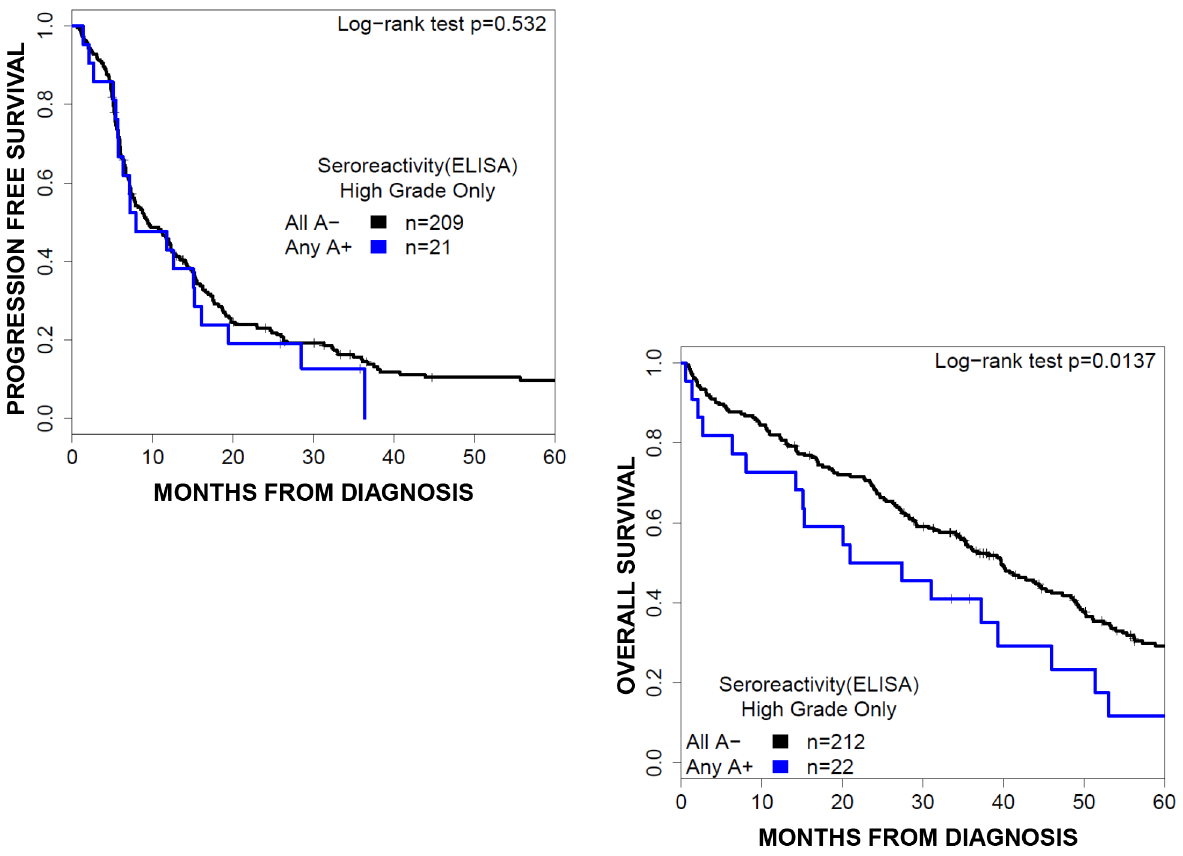
Figure 4. Survival by MAGE serology. Overall survival curves for patients groups based on the presence of anti-MAGE autoantibody. Humoral response to any MAGE antigen predicts poor overall survival, and no significant association with progression free survival.